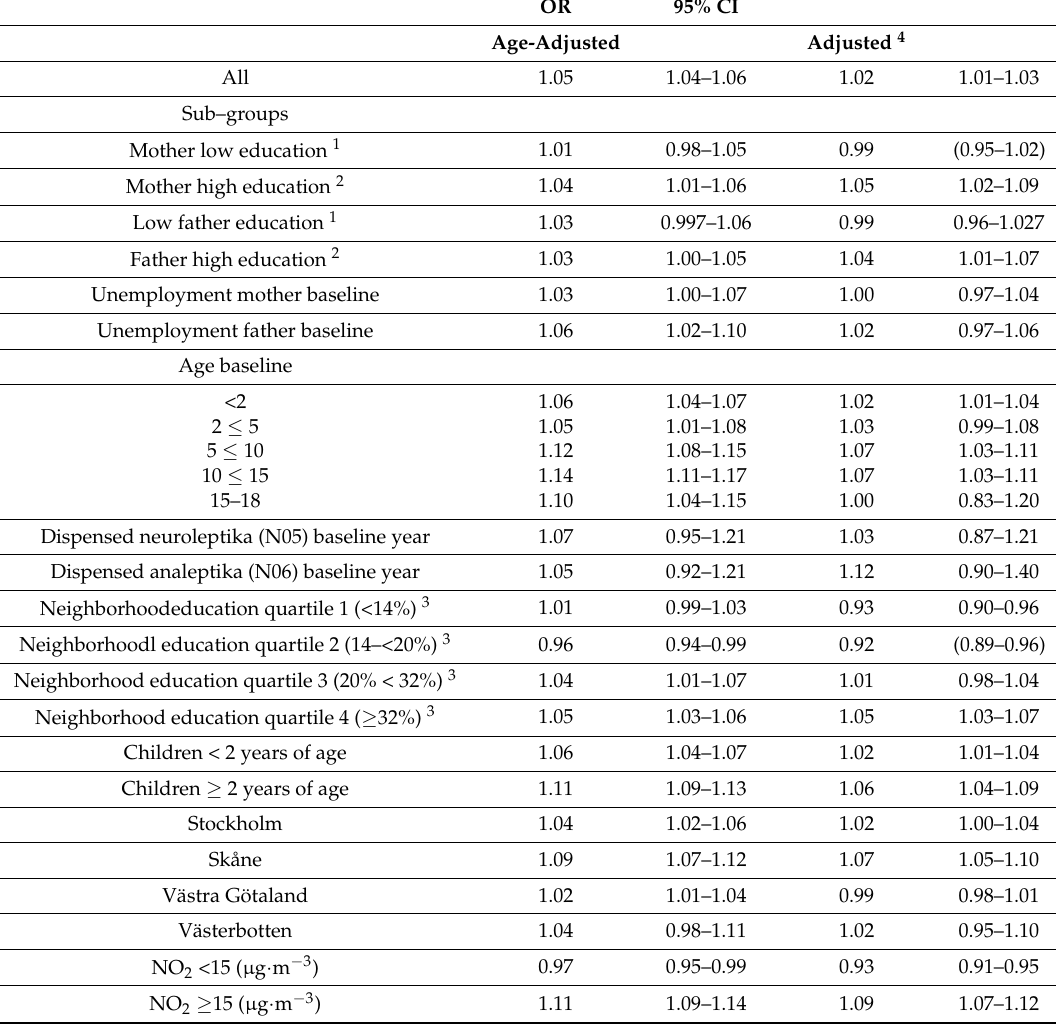
Table 2. Odds ratios (ORs) and their 95% Confidence Intervals (CIs) for asthma medication in association with a 10 ( µ g · m − 3 ) increase in NO 2 for all cohort members, and in sub-groups of the cohort.